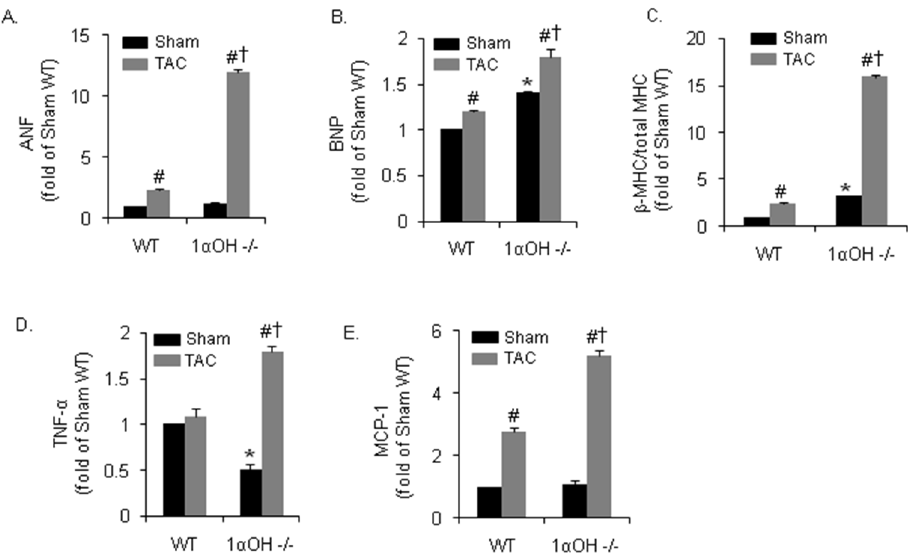
Figure 3. Biochemical findings after 4 weeks of Pressure overload in 1 a OHase 2 / 2 mice. (A–C) Real-time PCR mRNA expression of ANF (A), BNP (B) and of ß-MHC to total MHC ratio (C) in WT and 1 a -OHase 2 / 2 mice after 4 weeks of sham or TAC. *, p , 0.05 compared to WT. # , p , 0.05 compared to sham. { , p , 0.05 compared to WT TAC. N=8–10. (D and E) Real-time PCR mRNA expression of inflammatory cytokines TNF- a (D) and MCP-1 (E) in WT and 1 a -OHase -/- mice after 4 weeks of sham or TAC. *, p , 0.05 compared to WT. # , p , 0.05 compared to sham. { , p , 0.05 compared to WT TAC. N=8–10.